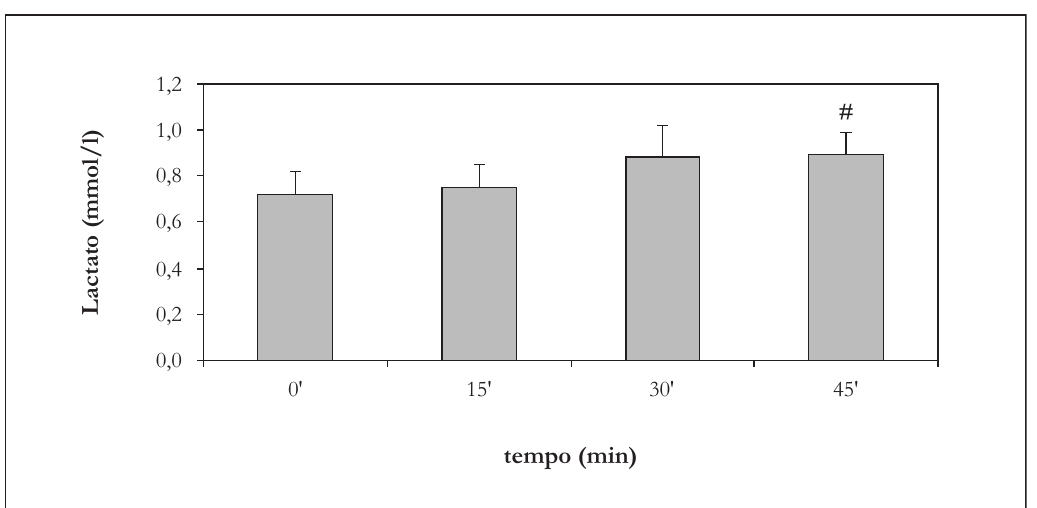
Figura 2 - Concentrações plasmáticas de lactato nos intervalos de 0 a 45 min. Os valores representam a média ± e.p.m. das 6 sessões de fisioterapia. # p ≤ 0,05 em relação ao tempo 0’ (Teste t de Student pareado)